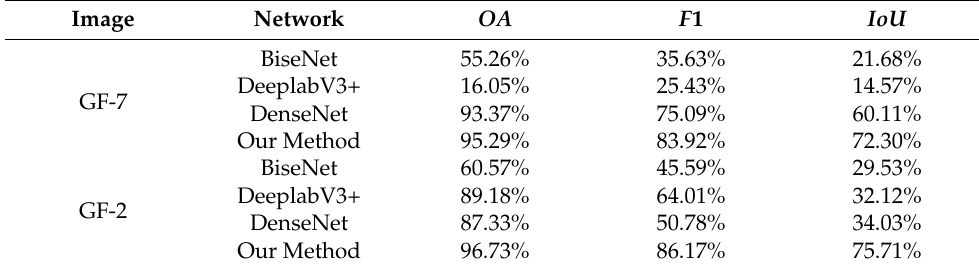
Table 2. Accuracy assessment of the different